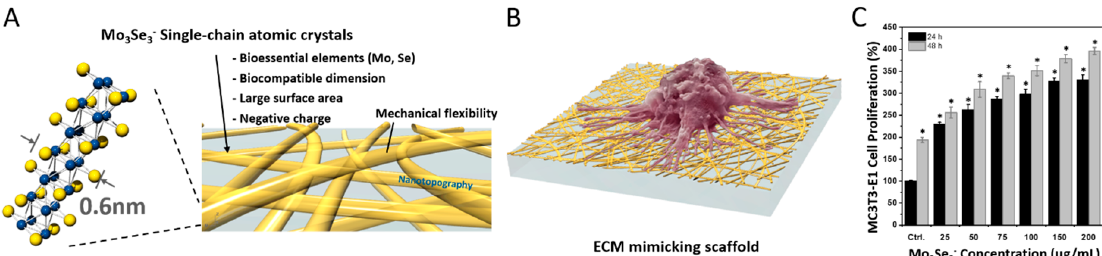
Figure 1. Mo 3 Se 3 − SCAC-based extracellular matrix (ECM) mimicking materials [34]. ( A ) Properties of Mo 3 Se 3 − SCACs to mimic ECM. ( B ) ECM-mimicking scaffold prepared by spray coating of Mo 3 Se 3 − SCACs onto a glass substrate. ( C ) Proliferation of MC3T3-E1 cell lines treated with media containing different concentrations of Mo 3 Se 3 − SCACs (* for p < 0.0001). All statistical analysis was performed with the control data. “Reprinted with permission from ref. [34]. Copyright 2018, American Chemical Society.”